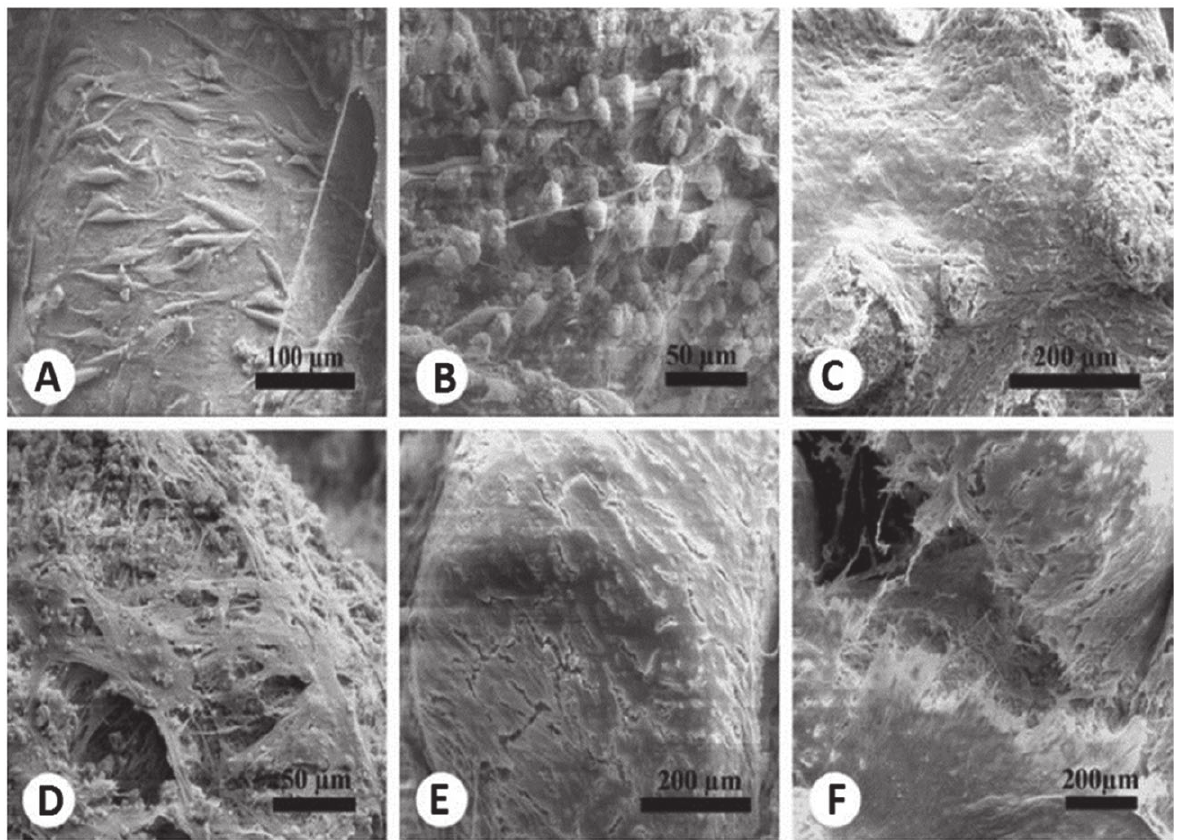
Figure 1 SEM images of osteoblastic cells on BONITmatrix ® -collagen scaffolds: (A – C) MG63 and (D – F) primary osteoblasts on human serum-coated scaffolds after (A, D) 1 day, (B, E) 7 days and (C, F) 10 days of culture, according to Ghanaati et al. [22] . Reproduced with per- mission from IOP